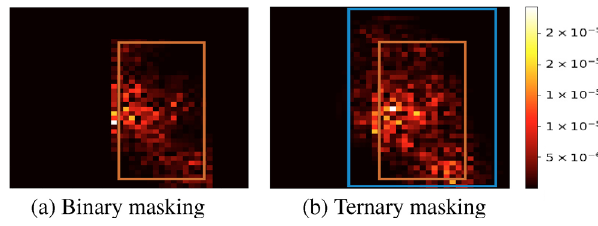
Fig. 6 Gradient maps using binary masking and ternary masking. Ternary masking considers more peripheral information about the region around the proposal. The input image is shown in Fig.